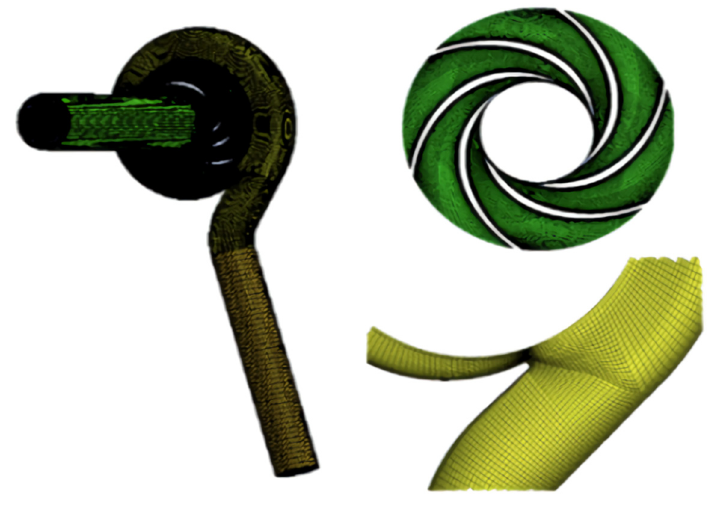
Figure 2. Model pump and meshing of each computational domain.